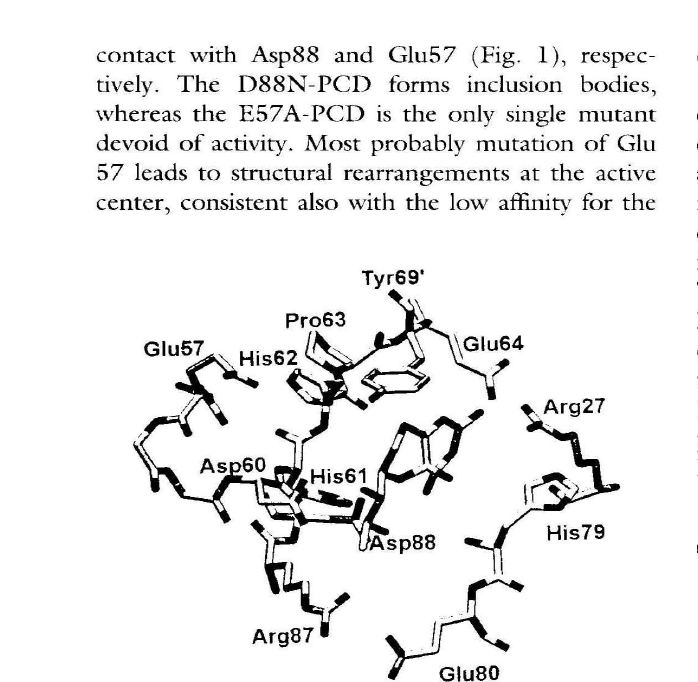
Figure 1. Active site residues of hwt-PCD with a docked 4a(S) - OH -7,8-dihydrobiopterin molecule. The docking \\'as achieved using the program SETOR [10]. His61 and His62 are in hydrogen bonding distance to either N(5)-H or N(8)-H of the substrate and are able to act as depro ronating bases. They are in hydrogen bond contact with ,\sp88 and Glu57, respectively. His79 or a water molecule ~an attack the substrate from the opposite face and might ;:>rotonate the 4a-OH group acting as a general acid adapted from [7]).